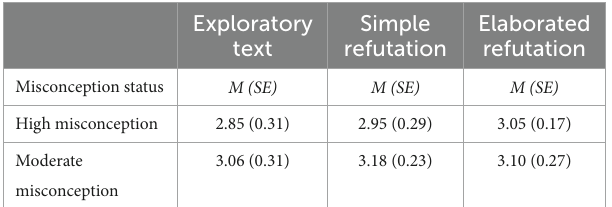
TABLE 2 Mean frequency and standard error by text type and misconception status for Cued Recall test.